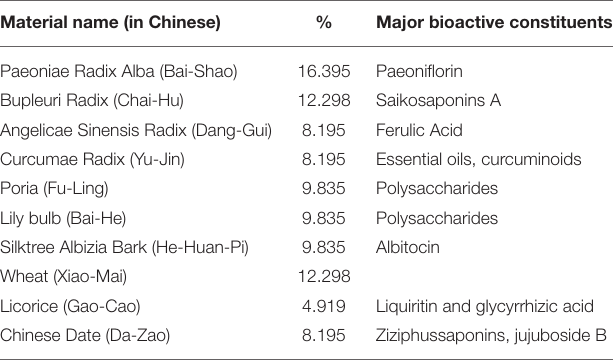
TABLE 1 | Individual Medicinal materials of the JYP formula a